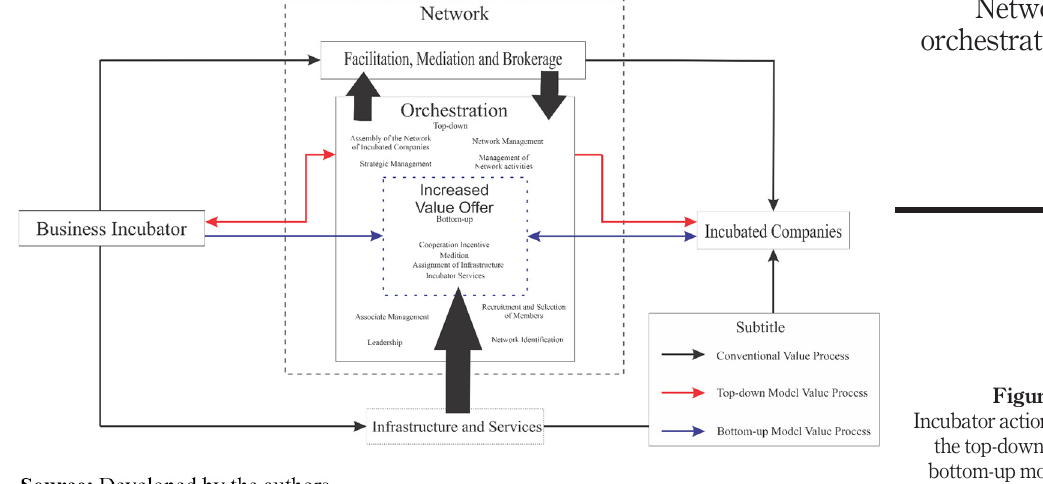
Figure 1. Incubator actions in the top-down and bottom-up